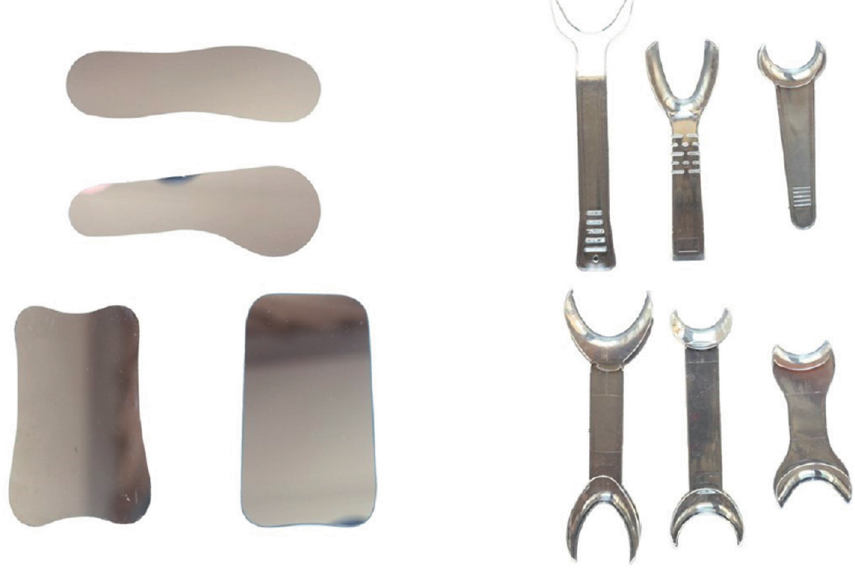
Figure 5: Intraoral mirrors and cheek retractors. Table 1: Summary of the technical differences between a DSLR and a smartphone in taking orthodontic photographs.